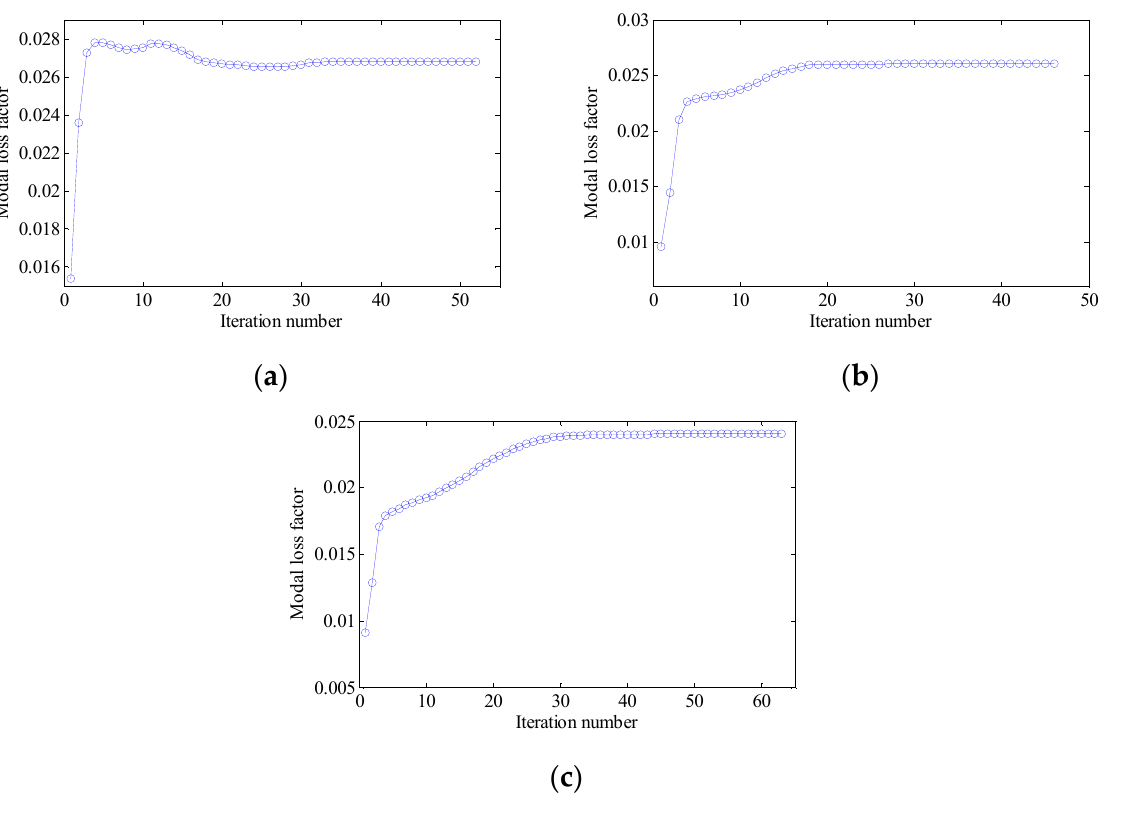
Figure 25. Iteration histories for maximizing the first modal loss factor: ( a ) Case 1: V MA